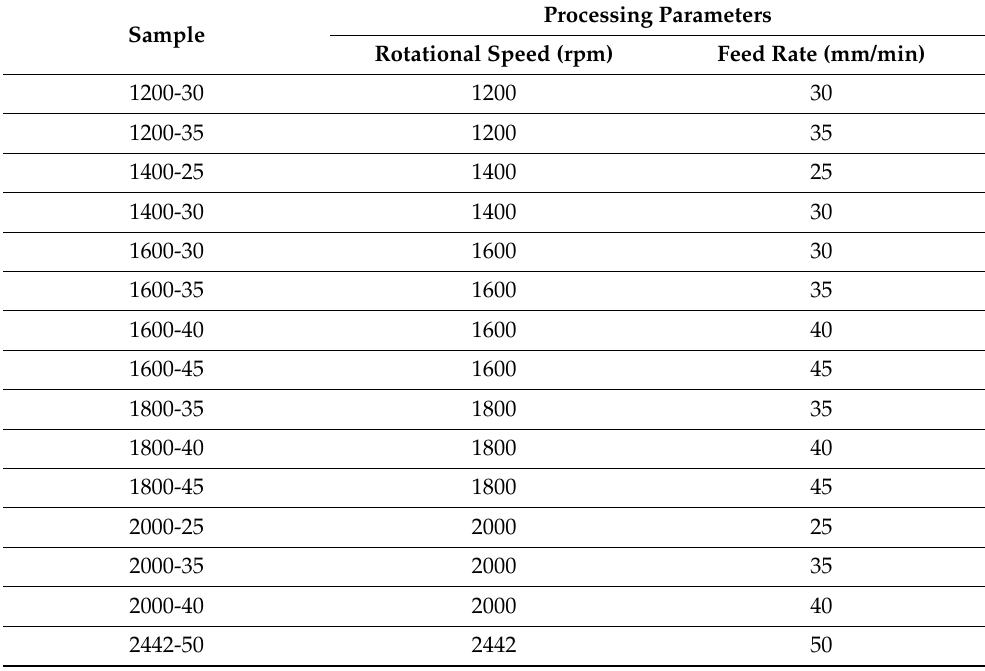
Figure 4. ( a ) Schematic diagram of friction stir processing and ( b ) FSPed recycled AA 6063/TiO 2 surface produced at 2442 rpm and 50 mm/min. Table 2. FSP parameters used for the fabrication of FSPed recycled AA 6063/TiO 2 surface composites